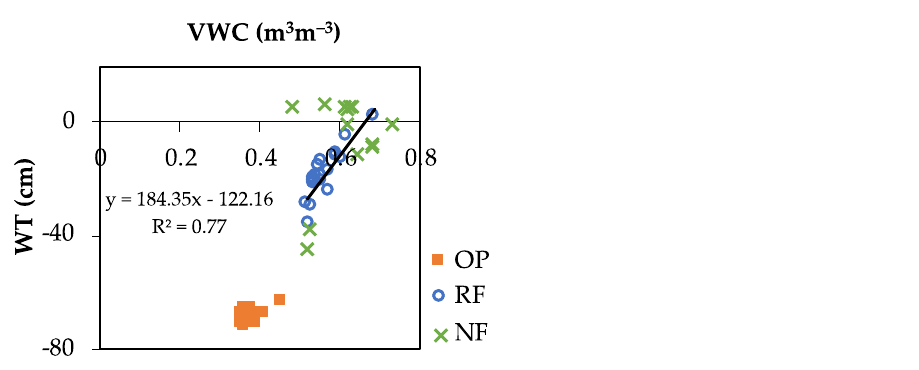
Figure 3. Relationship between water table level and soil moisture at at the oil palm plantation (OP), recovery peat swamp forest (RF) and natural peat swamp forest (NF) sites in Raja Musa, Malaysia.